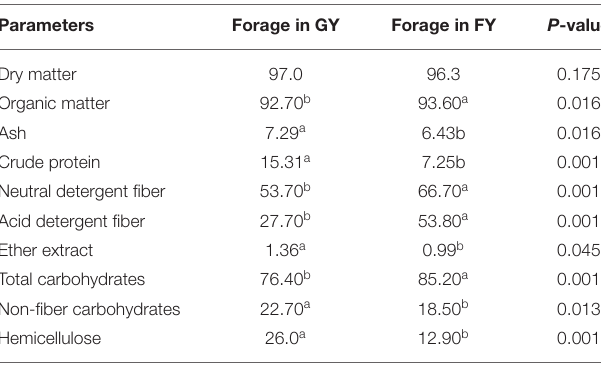
TABLE 1 | The chemical compositions of forages in natural grazing pasture and feedlot.